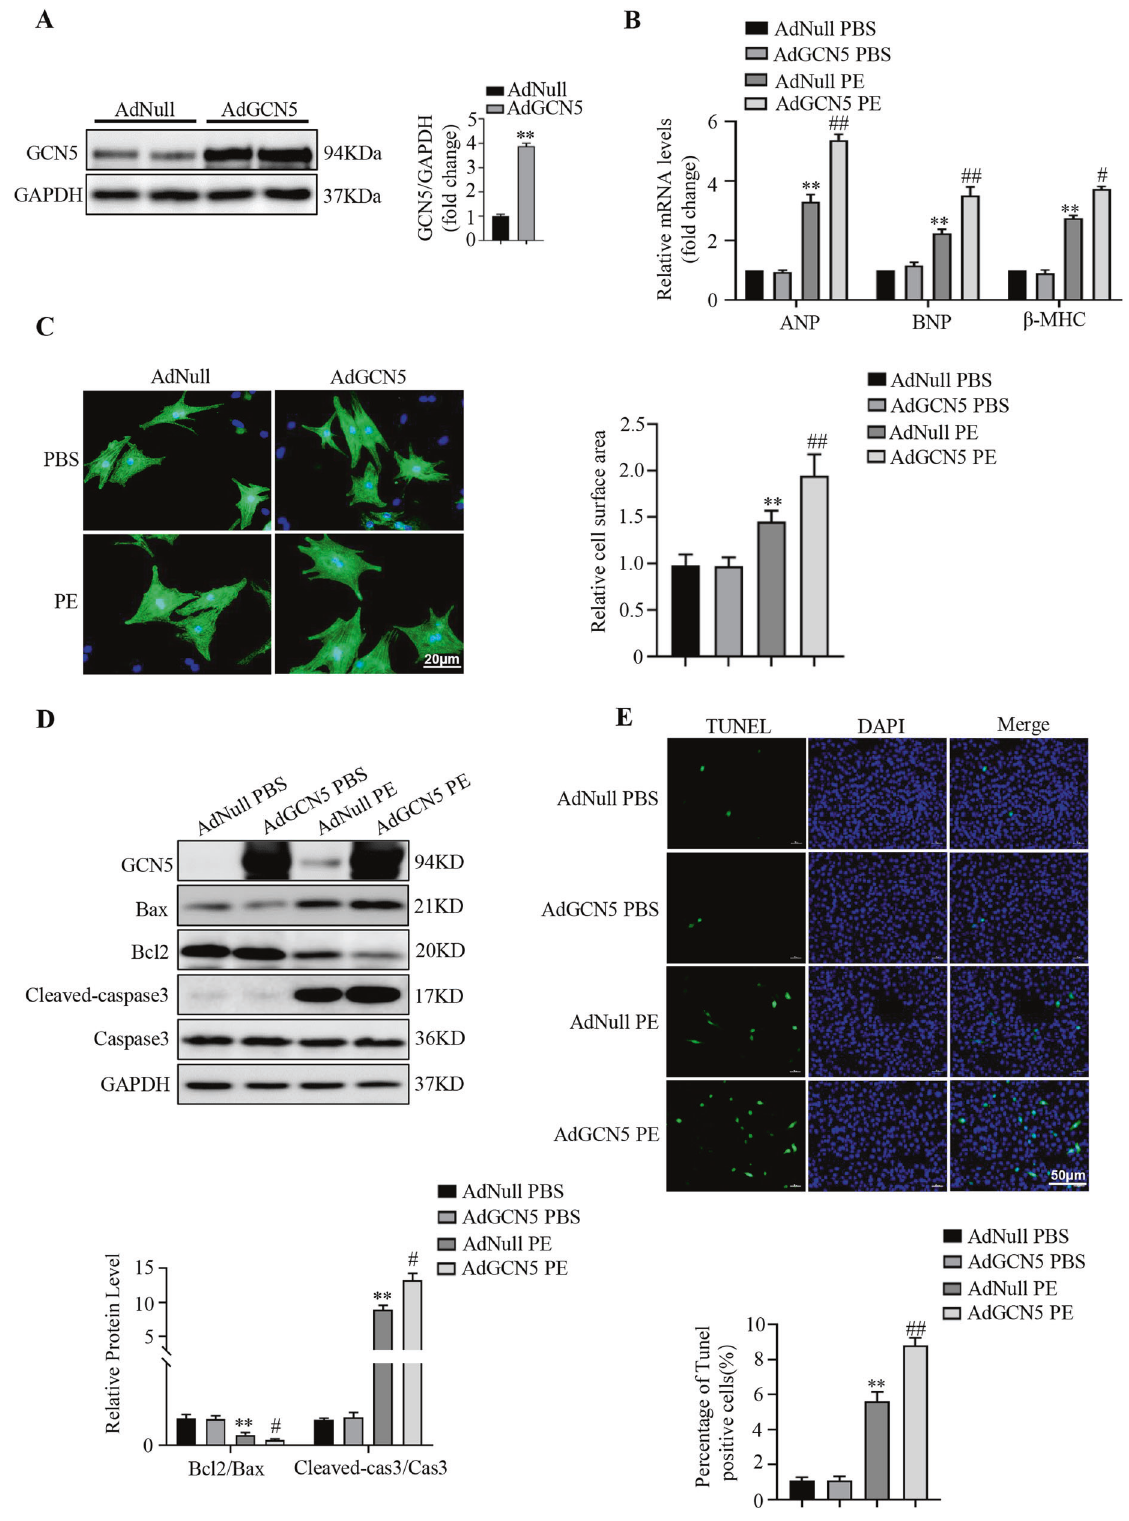
Fig. 3 GCN5 overexpression accelerates PE-induced cardiomyocyte hypertrophy and apoptosis. A Immunoblotting of primary cardiomyocytes infected with AdNull or AdGCN5 for 24 h to indicate GCN5 expression levels. B Effects of GCN5 overexpression on the mRNA levels of hypertrophic marker genes. C Effects of GCN5 overexpression on cardiomyocyte surface areas. D Western blots showing that overexpressed GCN5 exacerbates PE-induced NRCM apoptosis. E Representative images of TUNEL staining, indicating apoptotic rates of NRCMs ( ∗∗ P < 0.01 vs AdNull PBS; # P < 0.05 vs AdNull PE, ## P < 0.01 vs AdNull PE). Data are shown as the mean ± SD from three independent